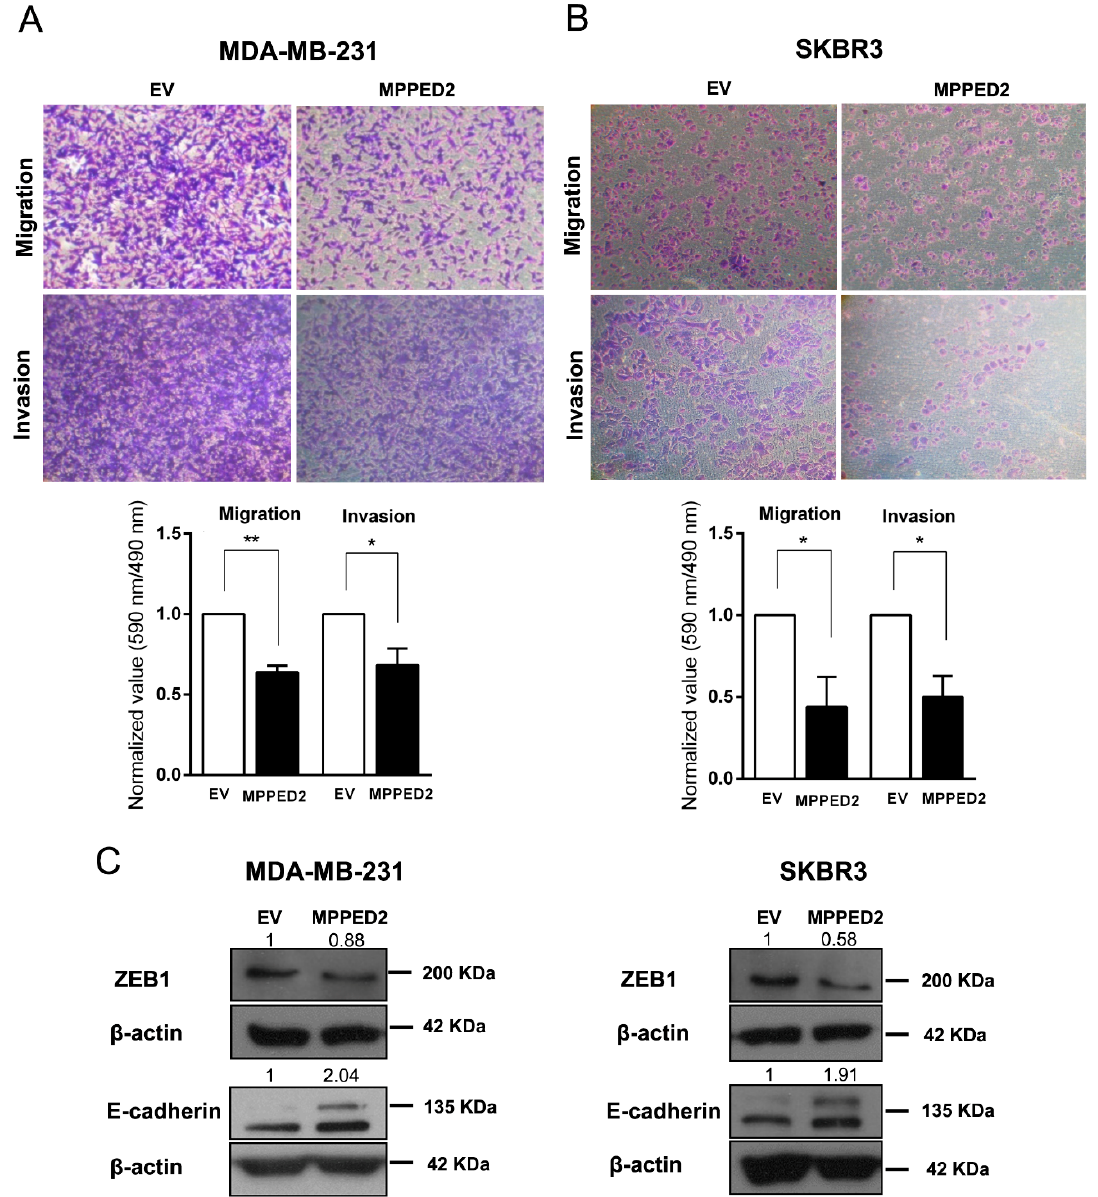
Figure 7. MPPED2 reduces cell migration and invasion of breast carcinoma cell lines. ( A , B ) Representative images of migration and invasion assays performed in MDA-MB-231 and SKBR3 cells stably transfected with MPPED2 or the corresponding empty vector (EV) (upper panel). Magnification 40 × . Migrated or invaded cells were fixed with crystal violet solution. After elution from transwell, it was quantified by reading its absorbance at 590 nm. Crystal violet absorbance values were divided by corresponded cell titer values (Materials and Methods) and were plotted in y -axis. Data obtained from three independent experiments carried out in MDA-MB-231 and SKBR3 cells are shown in the lower panel. Values are reported as mean value ± SD, compared to the EV, set equal to 1. t -test: *, p < 0.05, ** p < 0.01. ( C ) Western blot analysis of ZEB1 and E-cadherin in MD-MBA-231 (left panel) and SKBR3 (right panel) cells stably expressing MPPED2 or carrying the corresponding empty vector (EV). β -actin was used to normalize the amount of loaded protein. Densitometric analysis was performed by using ImageJ software to evaluate protein expression compared to EV, set equal to 1. Original blots were shown in Supplementary Materials Figure S7.